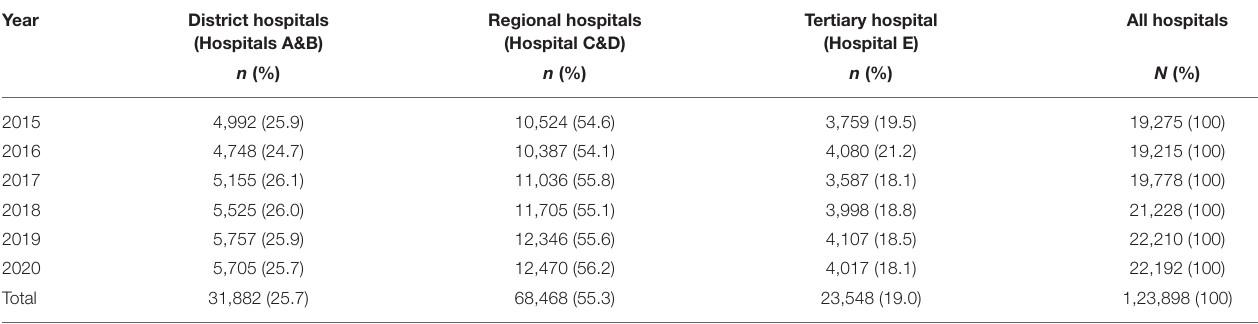
TABLE 1 | Annual number of births in the different hospitals.